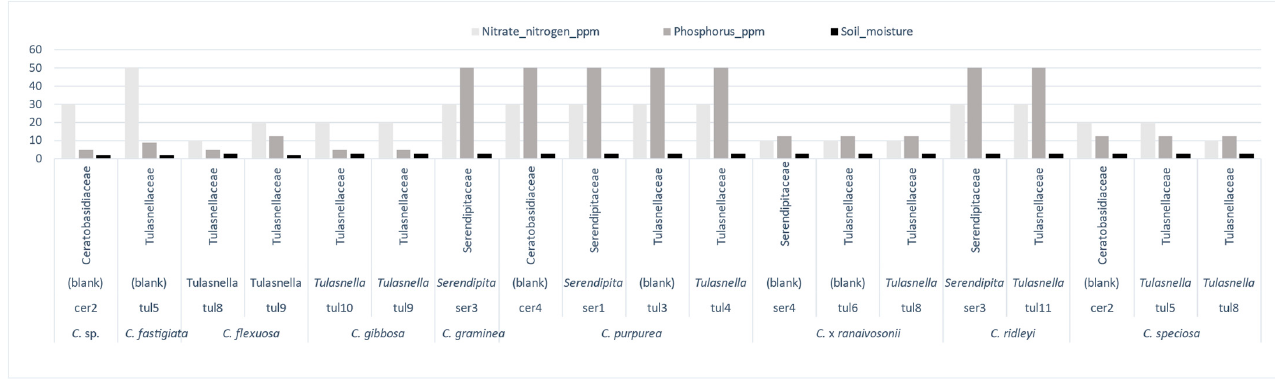
Figure 7. Distribution of putative mycorrhizal Operational Taxonomic Units (OTUs) (families and genera) in 11 species of Cynorkis at two different moisture levels, nitrogen, and phosphorus content (ppm).